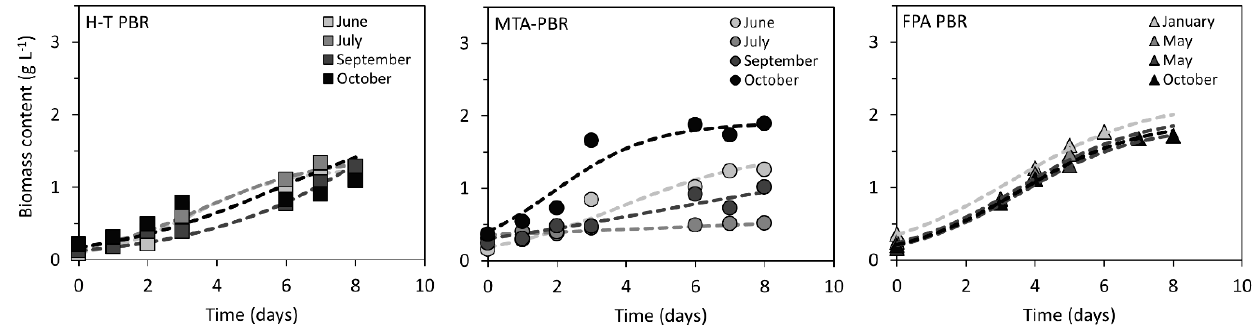
Figure 2. Growth of C. pyrenoidosa in H-T PBR, MTA PBR, and FPA PBR under nutrient sufficiency (as determined throughout the year 2018). Measured data points from individual cultivations were interpolated by logistic function (Equation (1)) using least squares fitting method. Data of C. pyrenoidosa growth under N limitation are summarized in Supplementary Figure S1.